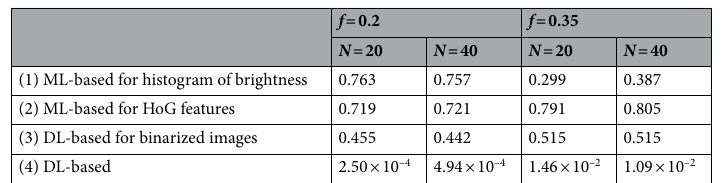
Table 3. Error rates for image classification for the 8-class